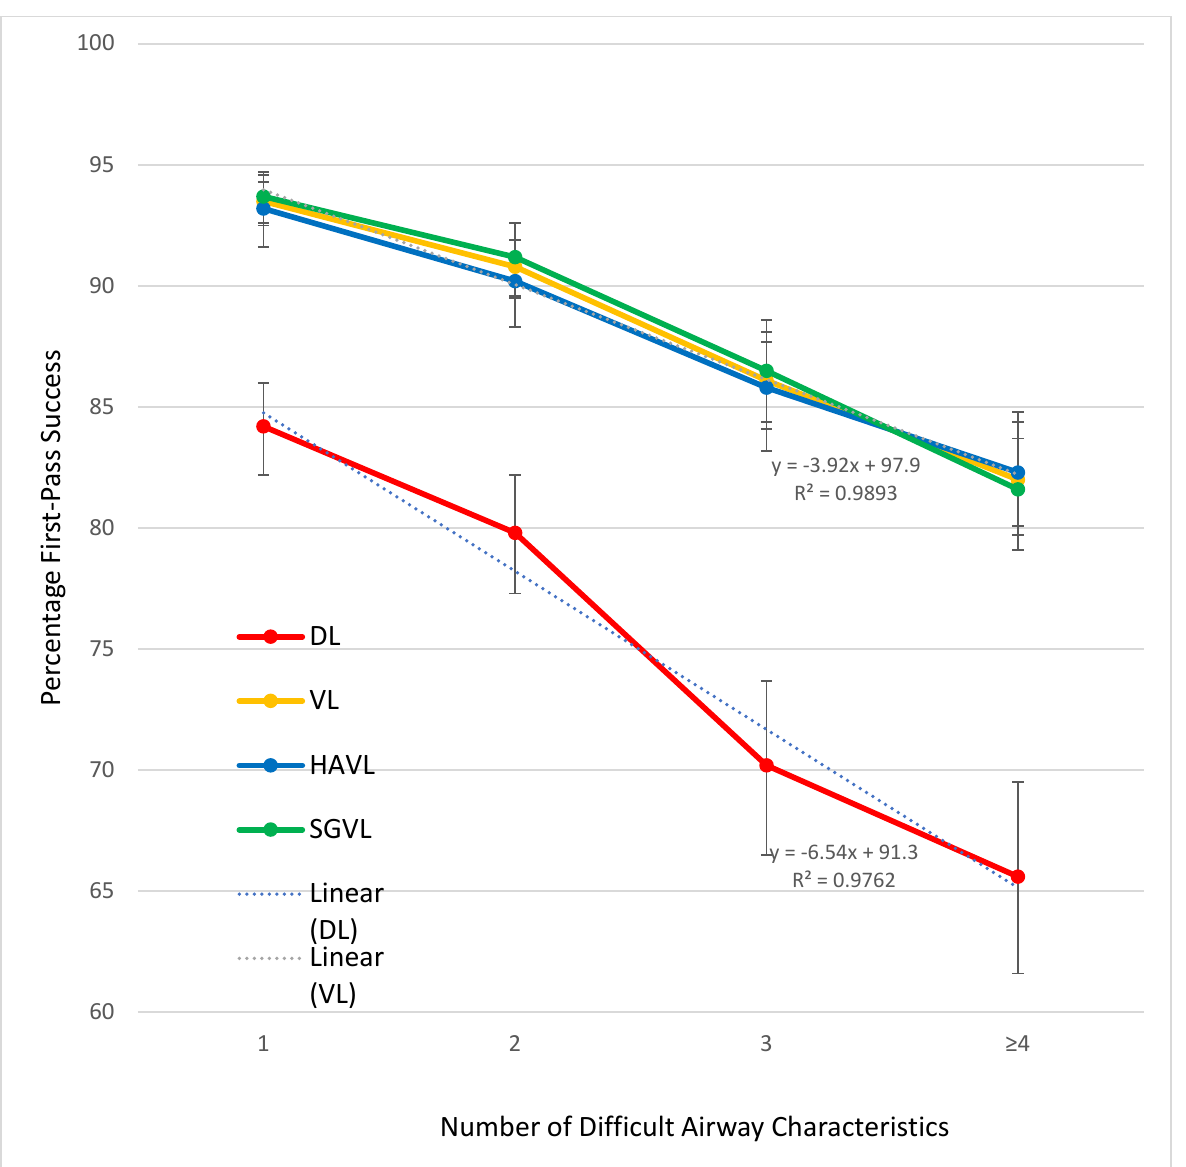
Figure 2. First-pass success rates for direct laryngoscopy (DL), video laryngoscopy (VL), hyperangulated VL (HAVL), and standard geometry VL (SGVL) for patients with multiple difficult airway characteristics. The percentage first-pass success is shown for DL, VL, HAVL, and SGVL for increasing numbers of distinct difficult airway characteristics. 95% confidence intervals are shown as error bars. Linear regression trendlines and their respective equations are shown for DL and VL. DL, direct laryngoscopy; VL, video laryngoscopy; FPS, first-pass success; HAVL, hyperangulated video laryngoscopy; SGVL, standard geometry video